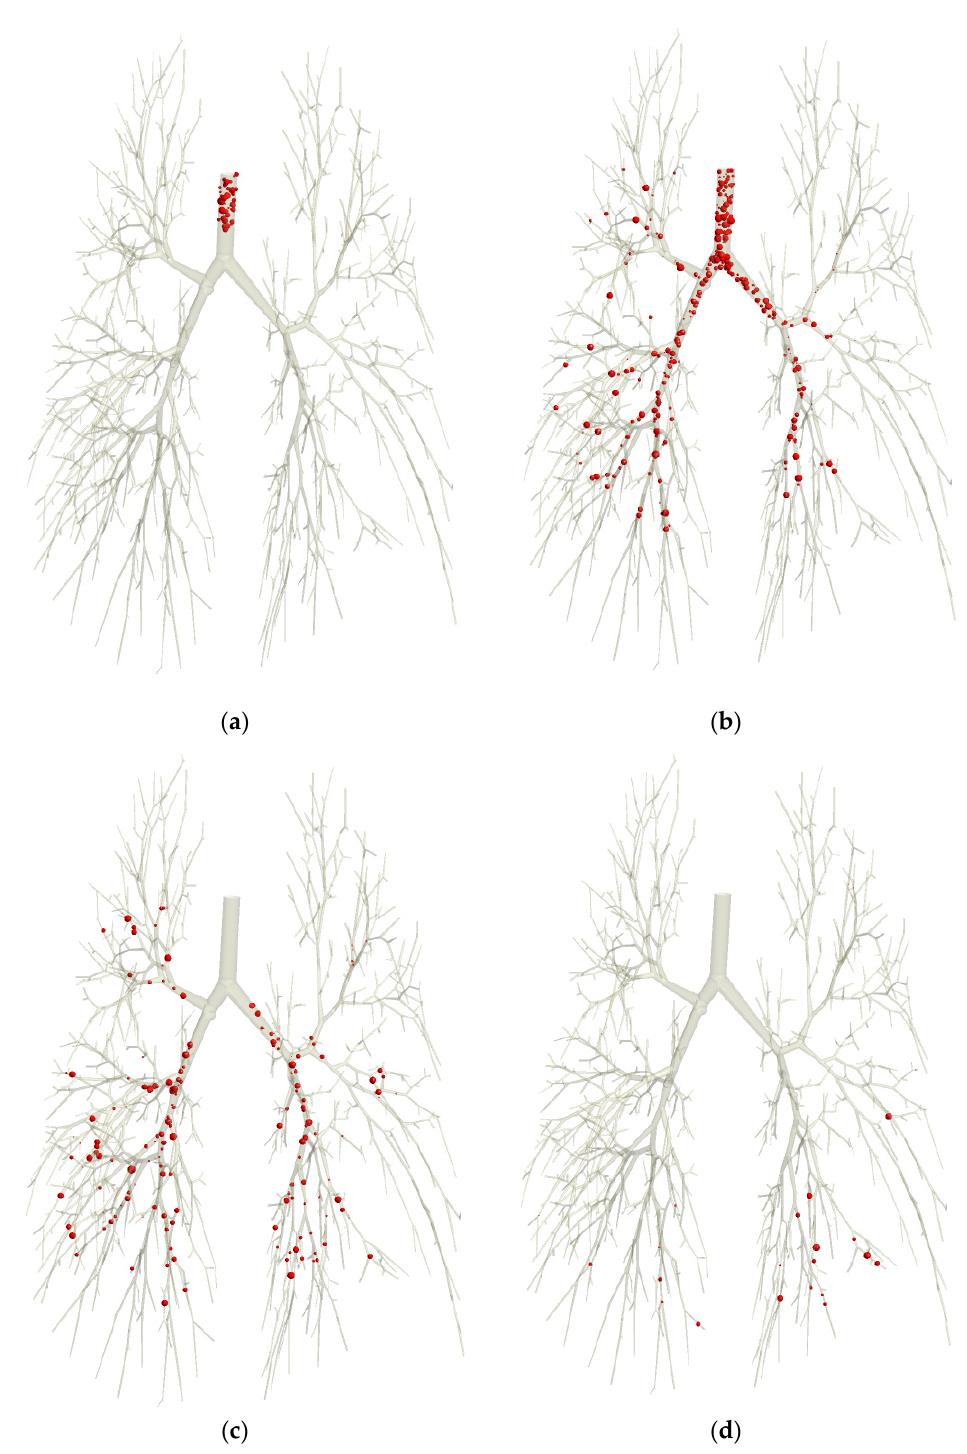
Figure 5. Movement progress of the computational particle parcels (without showing the deposited particles) at times t = 0.01 s ( a ), t = 0.09 s ( b ), t = 0.13 s ( c ), and t = 0.20 s ( d ) for the CFD test case P-1. Polydisperse particles (0.5 µm ≤ 𝐷 (cid:3028)(cid:3043) ≤ 5.5 µm) are injected, noted by the different (to scale) sphere sizes.